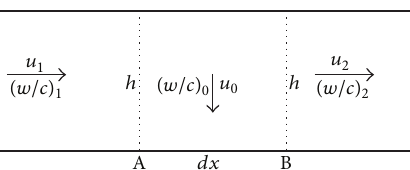
fractures and shares some internal relations with the mechan-